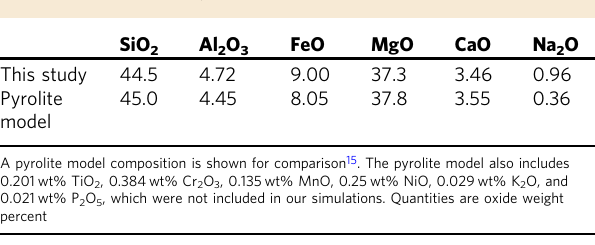
Table 1 Initial pyrolite composition used in this study to which CO and CO 2 species were